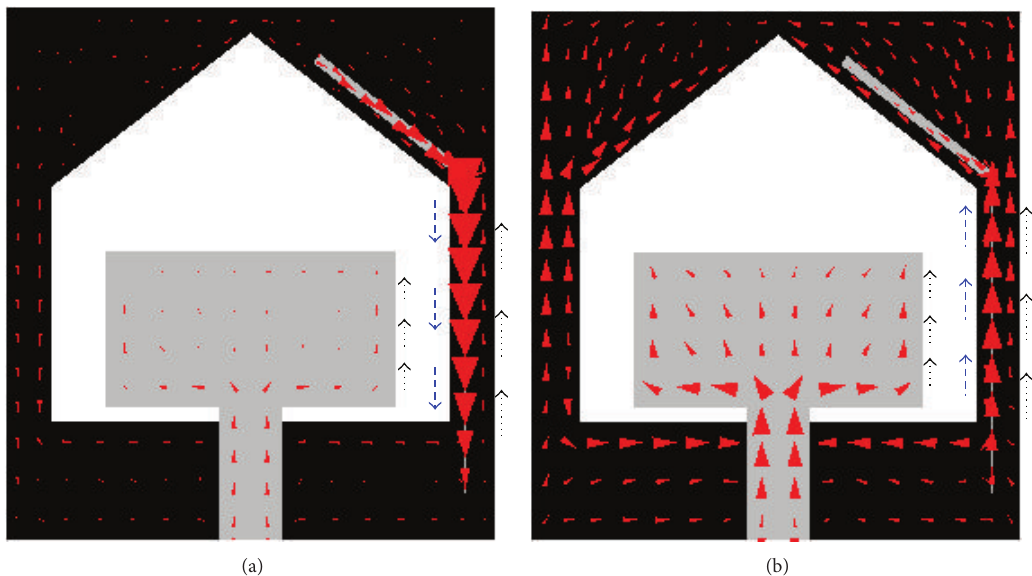
Figure 2: Surface current distribution at (a) 3.5 GHz (notch band) and (b) 5.5 GHz (pass band).